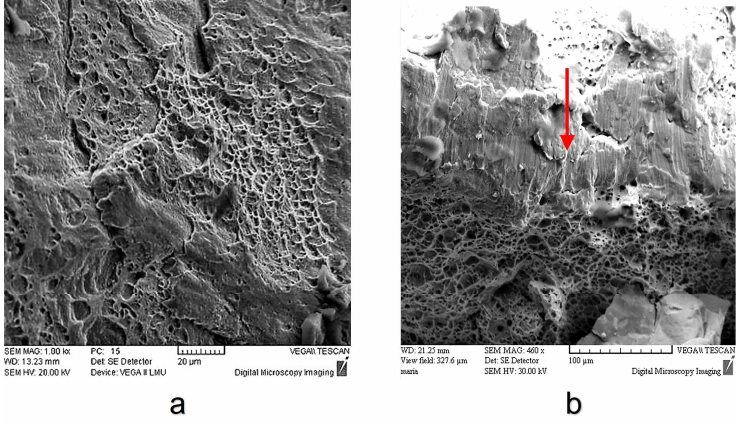
Figure 18. SEM micrographs of the fracture surface of 316L steel at 450 °C ( a ) and 500 °C ( b ).